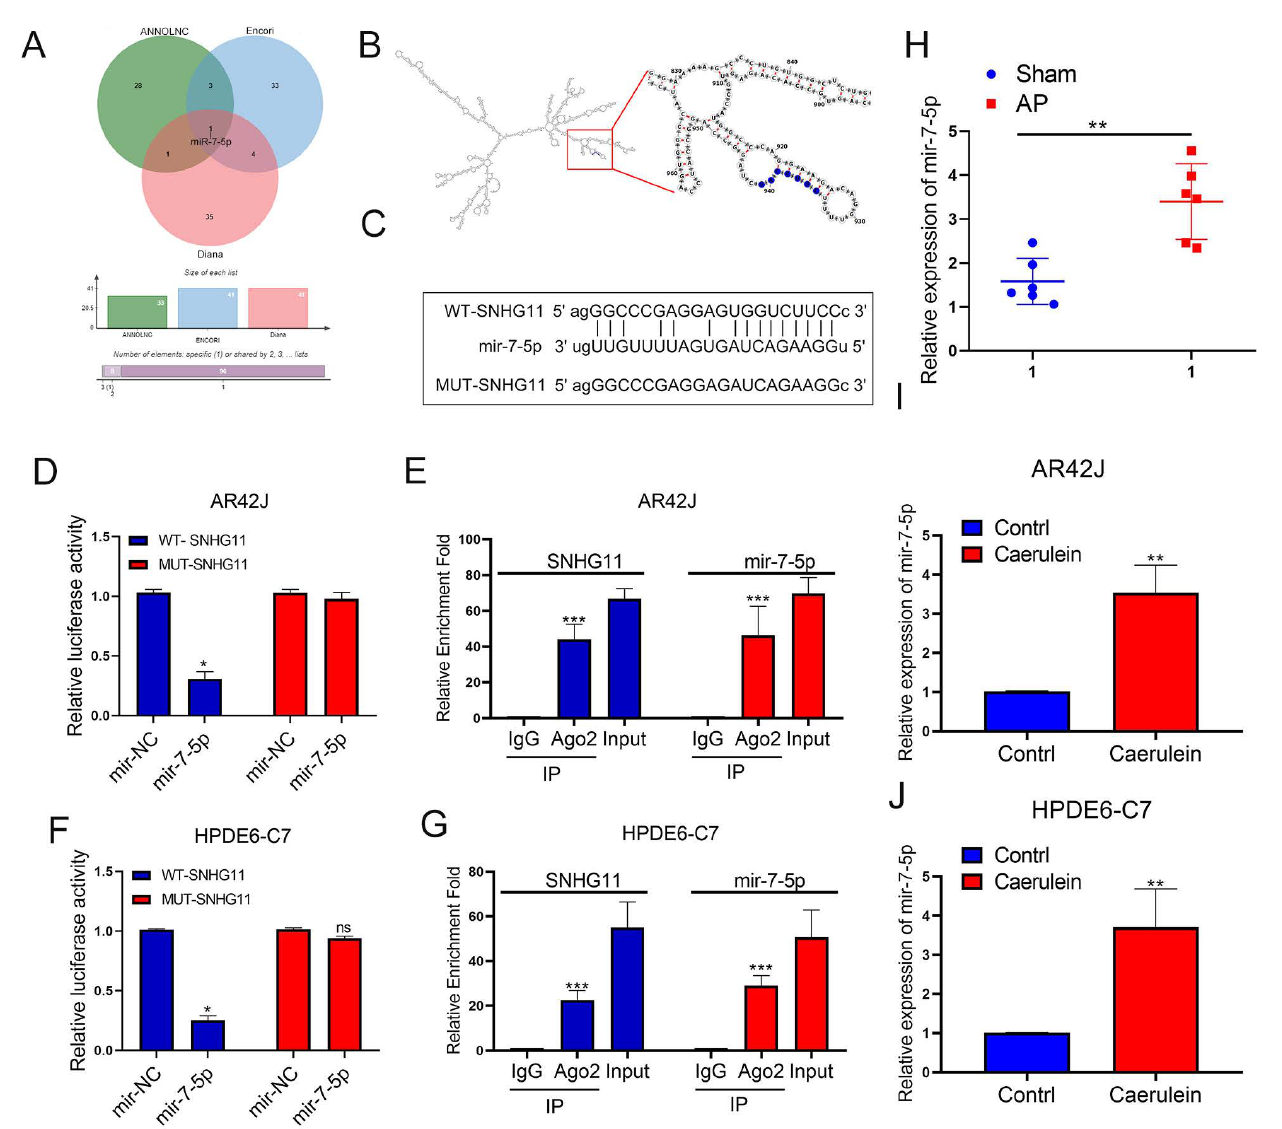
Figure 3. MiR-7-5p binds to lncRNA-SNHG11 in pancreatic cells. ( A ) Prediction of potentially downstream miRNAs bound to SNHG11 by Annolnc, Encori, and Diana databases. ( B ) Prediction of the binding position of SNHG11 and miR-7-5p through the secondary structure of SNHG11. ( C ) Schematic diagram of the MUT-SNHG11 plasmid. ( D – G ) The relationship between SNHG11 and miR-7-5p was verified by dual-luciferase reporter assay and RIP assay in AR42J and HPDE6-c7 cells. ( H – J ) The expression of miR-7-5p was assessed in rat tissues, AR42J, and HPDE6-C7 cells. The data are presented as means ± SDs, n = 3 for each group, * p < 0.05; ** p < 0.01; *** p < 0.001, ns = no significance between the indicated